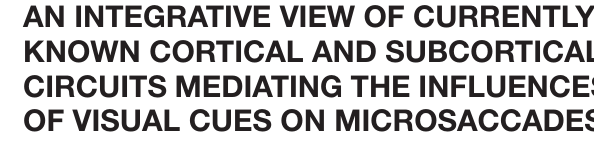
Frontiers in Neural Circuits |